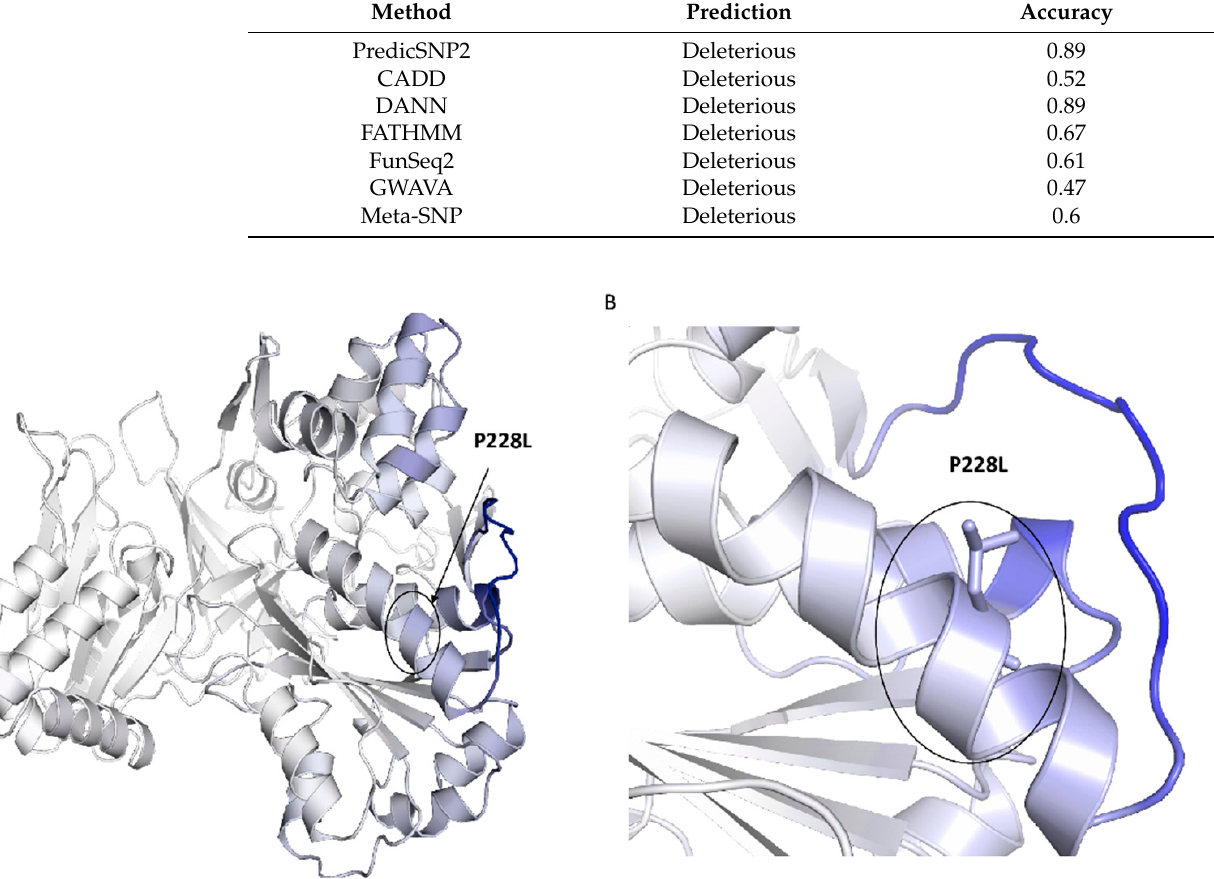
Table 2. In silico predictions of protein stability upon single amino acid change using sequence- based tools. Reference human POR sequence NCBI: NP_000932.3.